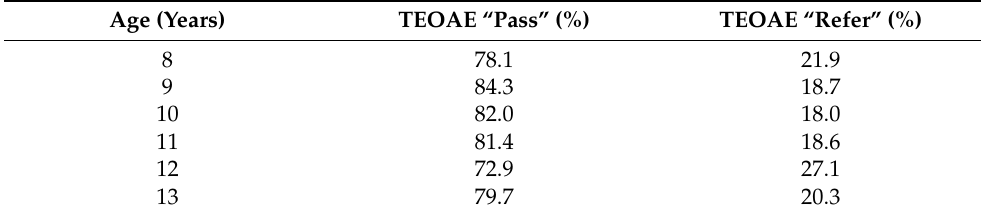
Table 4. Summary of TEOAE pass and refer percentages according to